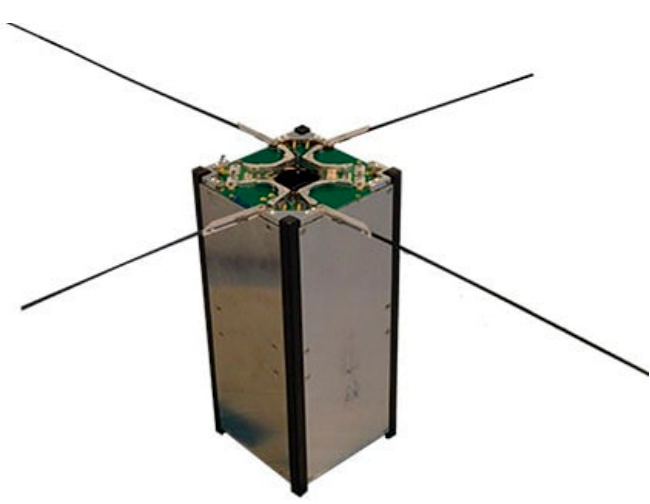
Figure 29. ISIS VHF/UHF Antenna [47].